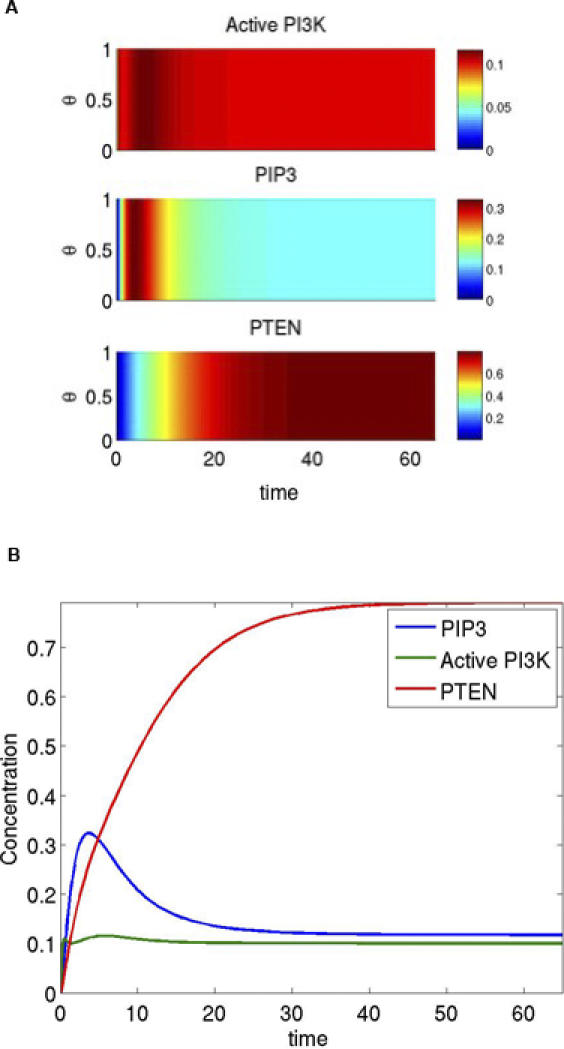
Partial Adaptation to a Uniform Increase in Chemoattractant(A) Adaptation around cell periphery.(B) Dynamics of adaptation at one point on the membrane (θ = 0.5).